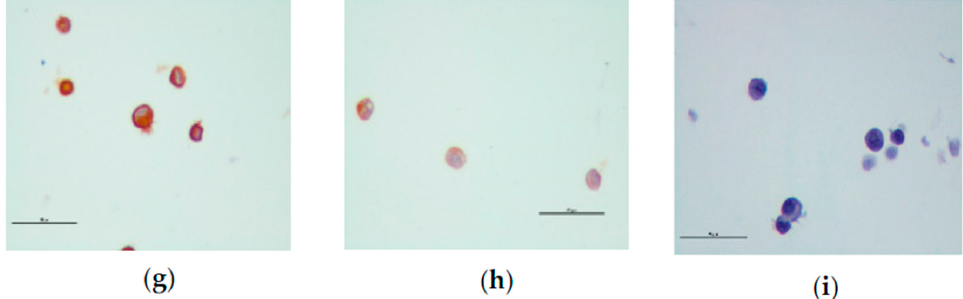
Figure 10. Expression of EMT markers, AE1/AE3, E-cadherin and vimentin in MCF-7 cells, by immunocytochemistry. All images were obtained through the same pool of cells, but in different cell blocks, in a magnification of 400x. ( a – c ) represent the positive controls for AE1/AE3, E-cadherin and vimentin, respectively. ( d – f ) represent images of cells treated with 5-FU combined with verapamil and tested for the presence of AE1/AE3, E-cadherin and vimentin, respectively. Images of cells treated with 5-FU combined with itraconazole and tested for the presence of AE1/AE3, E-cadherin and vimentin are represented by ( g – i ), respectively. Scale bar: 50 μ m.